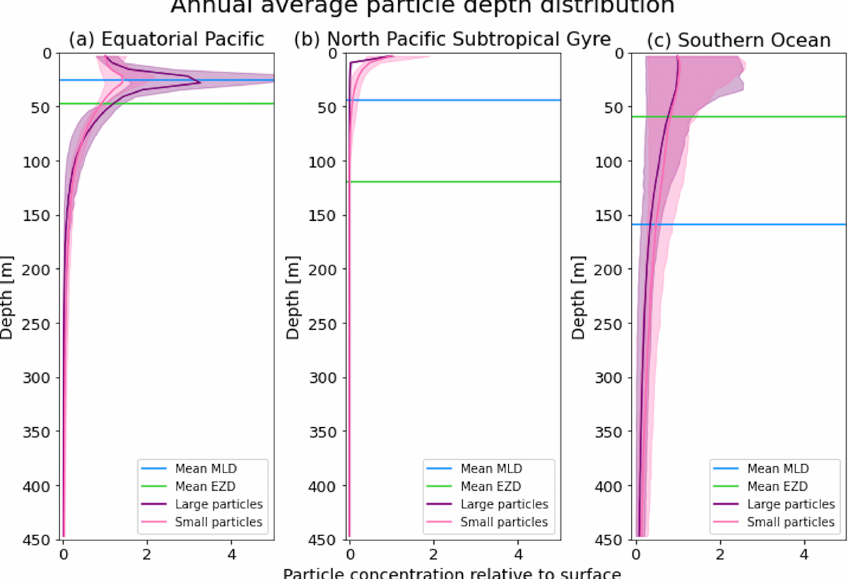
Figure 3. The annual average depth distribution of the trajectories in Fig. 2. Distributions down to 450m for the three regions shown: (a) equa- torial Pacific, (b) North Pacific Subtropical Gyre and (c) Southern Ocean. The x axis shows the particle concentration relative to the surface at z = 0 . 6m (where the surface concentration is 1 and 5 is 5 times the concentration of particles at the surface). Large particles (0.1–1mm) are shown in purple, and small particles (0.01–0.1mm) are shown in pink. The 5th–95th percentiles shaded around the mean are also shown, as well as the annual average mixed-layer depth (MLD; blue horizontal line) and euphotic-zone depth (EZD; green horizontal line) from Fig.